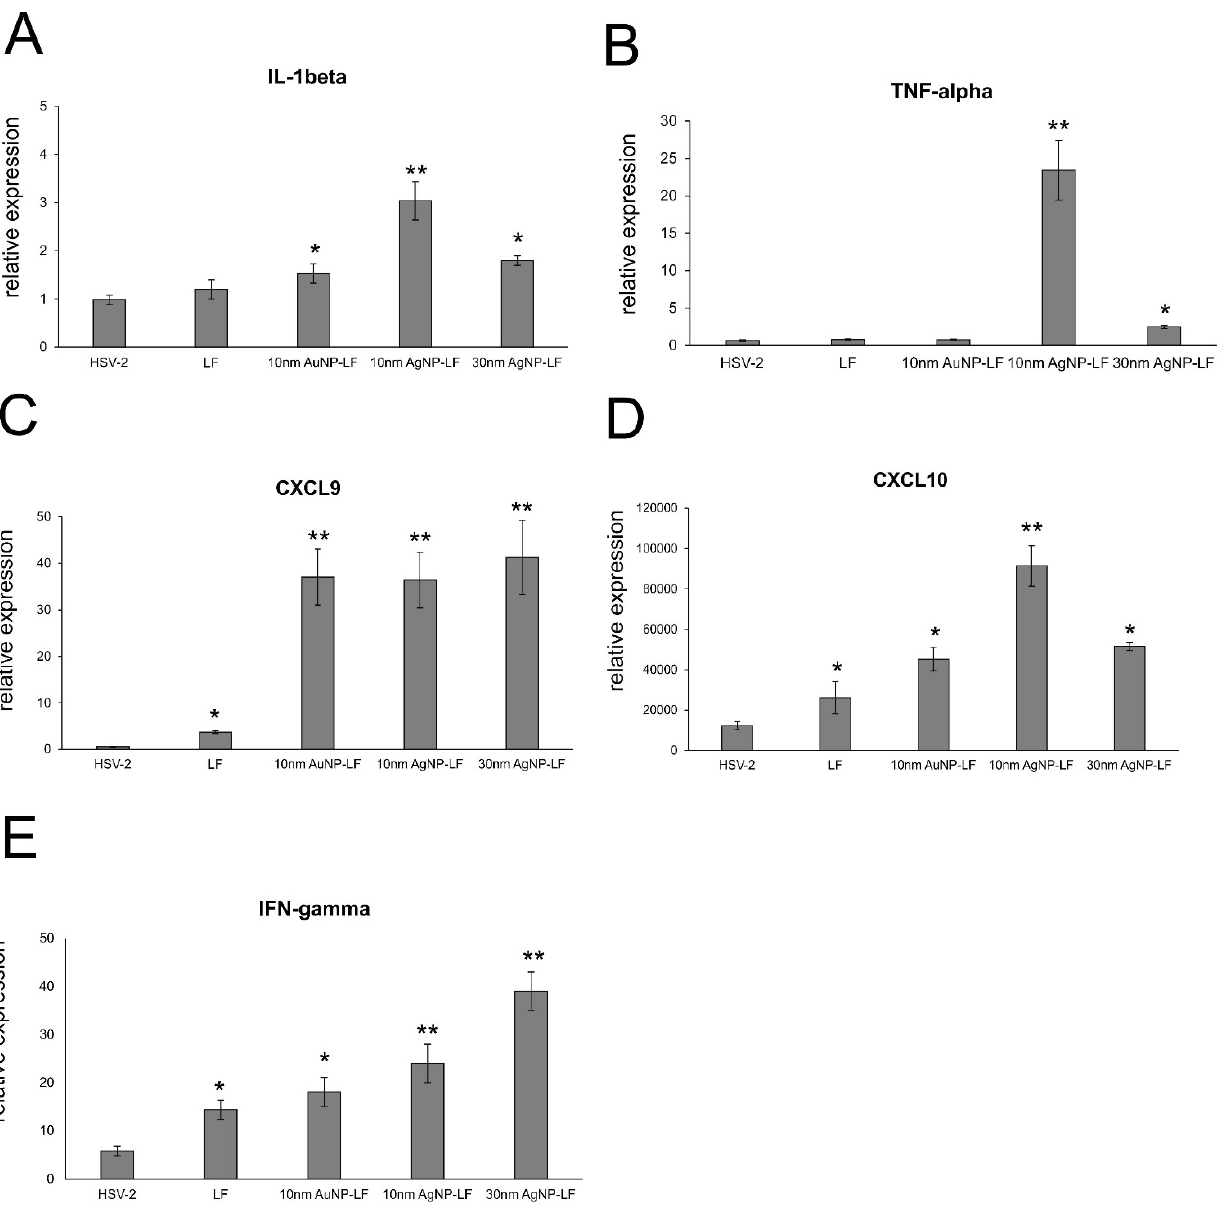
Figure 7. Cytokine and chemokine expression changes in the vaginal tissues at 7 day p.i. and treatment with lactoferrin modified Ag/AuNPs. Levels of IL-1 β ( A ), TNF- α ( B ), CXCL9 ( C ), CXCL10 ( D ), and IFN- γ ( E ) mRNA are shown as expression relative to control on the basis of the 2 ∆∆ Ct method. N = 7. * represents significant differences with p ≤ 0.05, ** p ≤ 0.01 in comparison to untreated HSV-2 tissues.